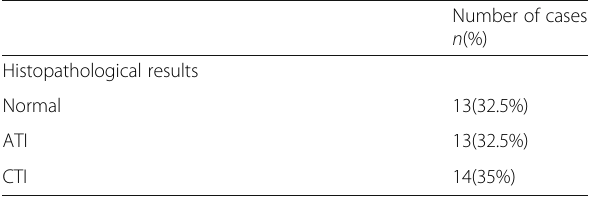
Table 2 Histopathological results of our 40 patients